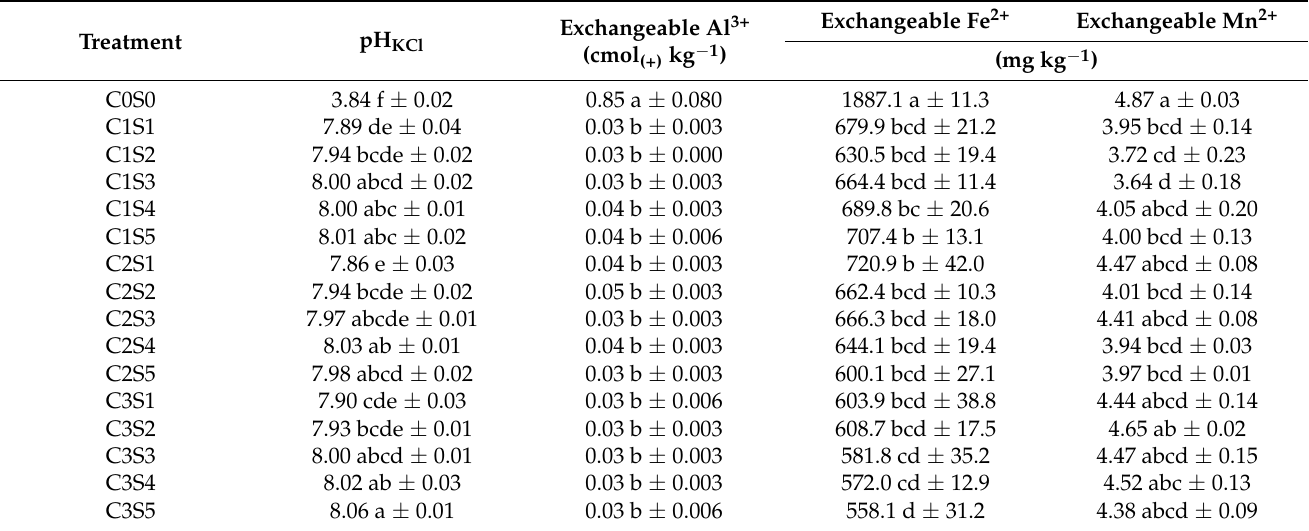
Figure 1. pH of leachates for the different treatments over 30 days of leaching. Table 3. Mean soil pH KCl , exchangeable aluminium, iron, and manganese for the different treatments after thirty days of leaching.